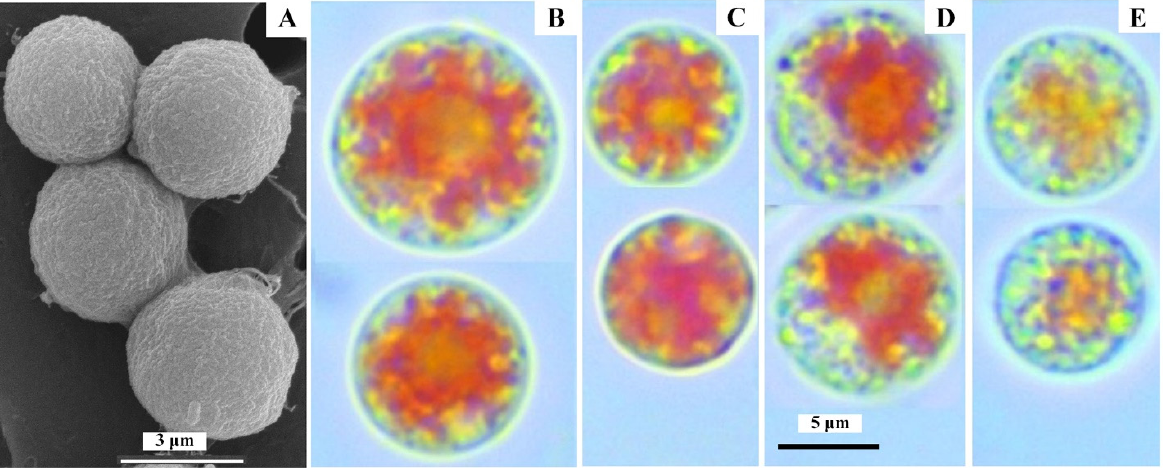
Figure 2. Cells of P . purpureum culture under the different methods of carbon introduction into pho-